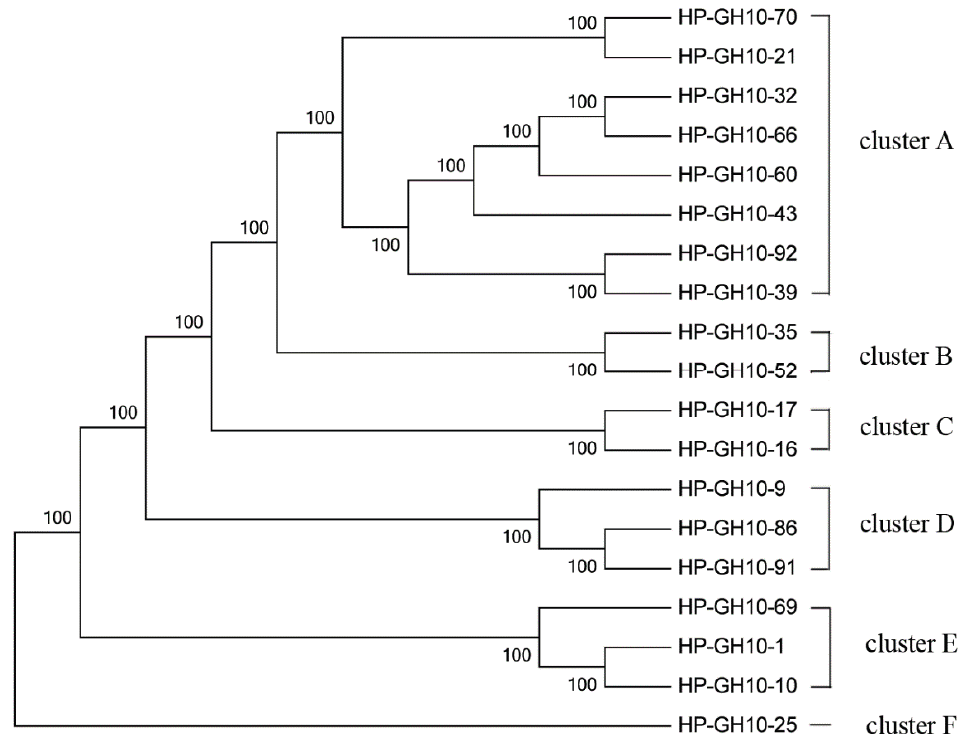
Figure 5. Maximum Likelihood phylogenetic tree of the GH36 amino acid sequences.